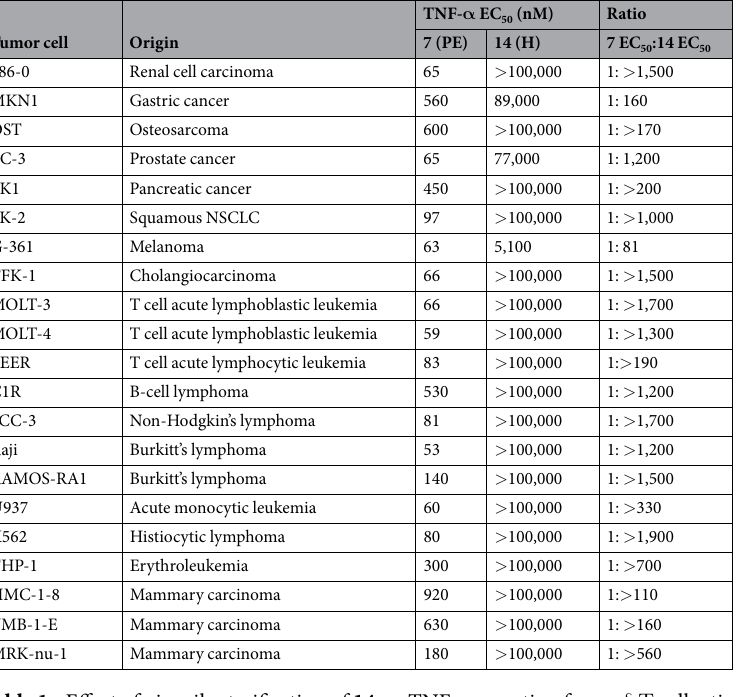
Table 1. Effect of pivoxil esterification of 14 on TNF- α secretion from γδ Τ cells stimulated with bisphosphonate-pretreated tumor cells. The concentrations of compounds 7 (pivoxil ester prodrug) and 14 (acid form) required to stimulate half maximal TNF- α secretion (EC 50 ) from γδ Τ cells in response to various tumor cell lines incubated with 7 or 14 are